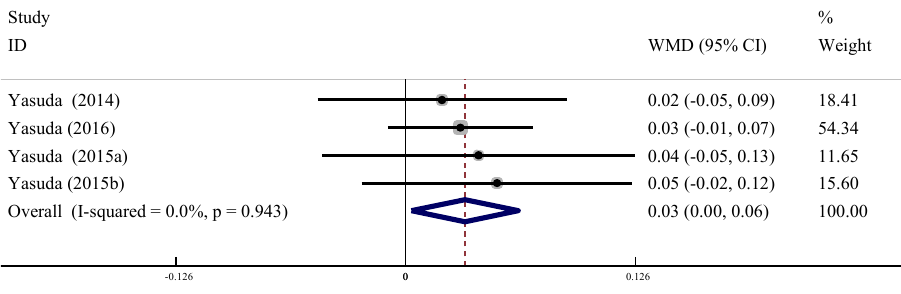
Figure 13. Meta-analysis of the effect of LL-BFR training on ABI of the older adults.